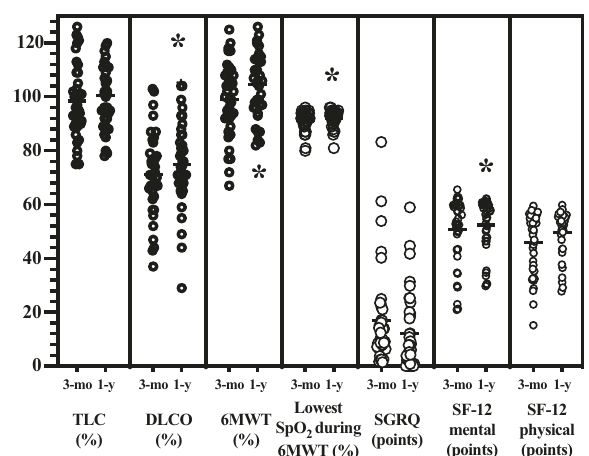
Fig. 3 Comparison of lung function tests, 6 min walk test, lowest SpO2 during 6MWT and health-related quality of life question- naires (SGRQ and SF-12) at 3- and 12-month follow-ups. Each variable was represented as mean ± SD or median and 25 th – 75 th percentile as